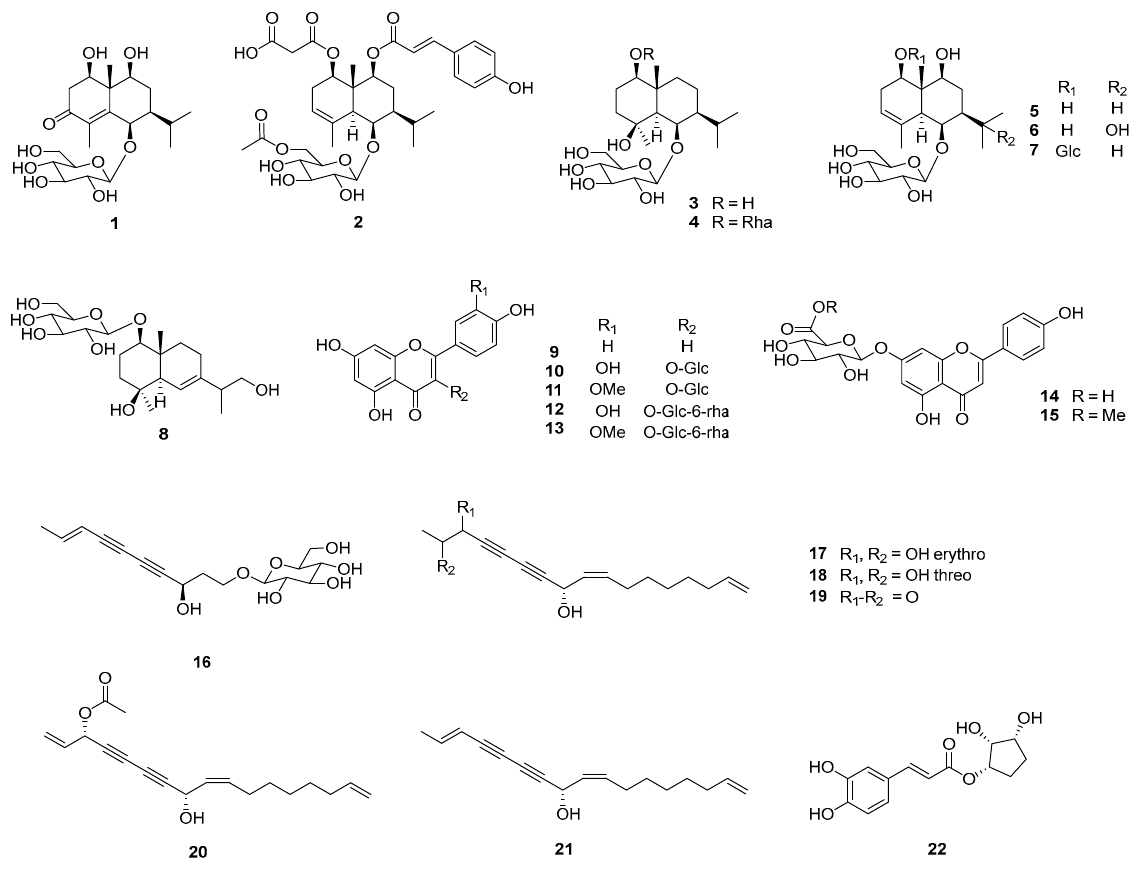
Figure 1. Structures of isolated compounds from the flowers of Aster koraiensis